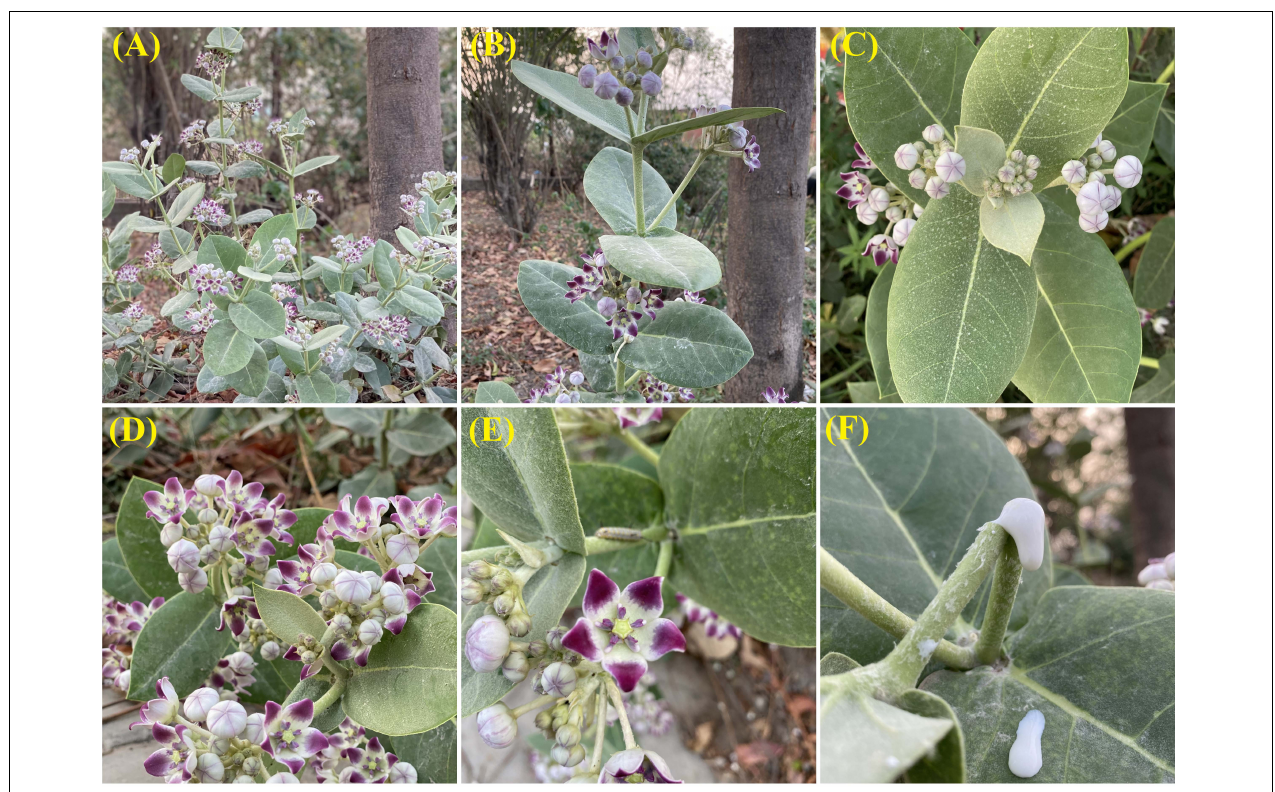
FIGURE 2 | Calotropis procera : flowering plant (A) ; phyllotaxy (B) ; reproductive buds (C) ; inflorescence (D) ; individual flower (E) ; and latex oozing out of the wounded stem (F) .